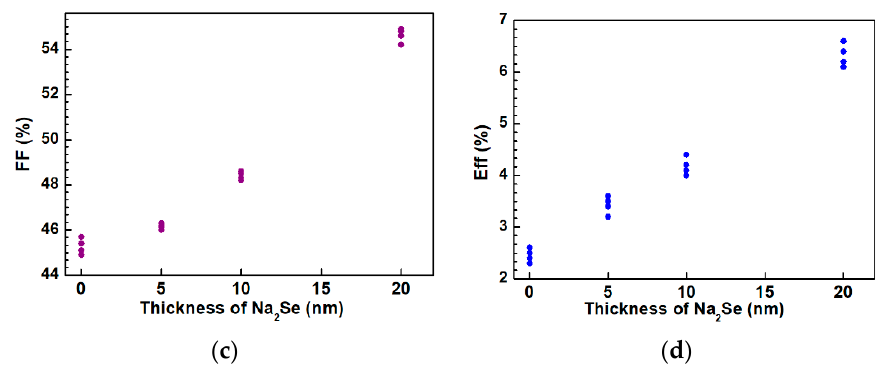
Figure 13. Photovoltaic parameters of solar cells as a function of Na 2 Se thickness: ( a ) Open-circuit voltage, ( b ) short-circuit current, ( c ) fill factor, and ( d ) conversion efficiency.